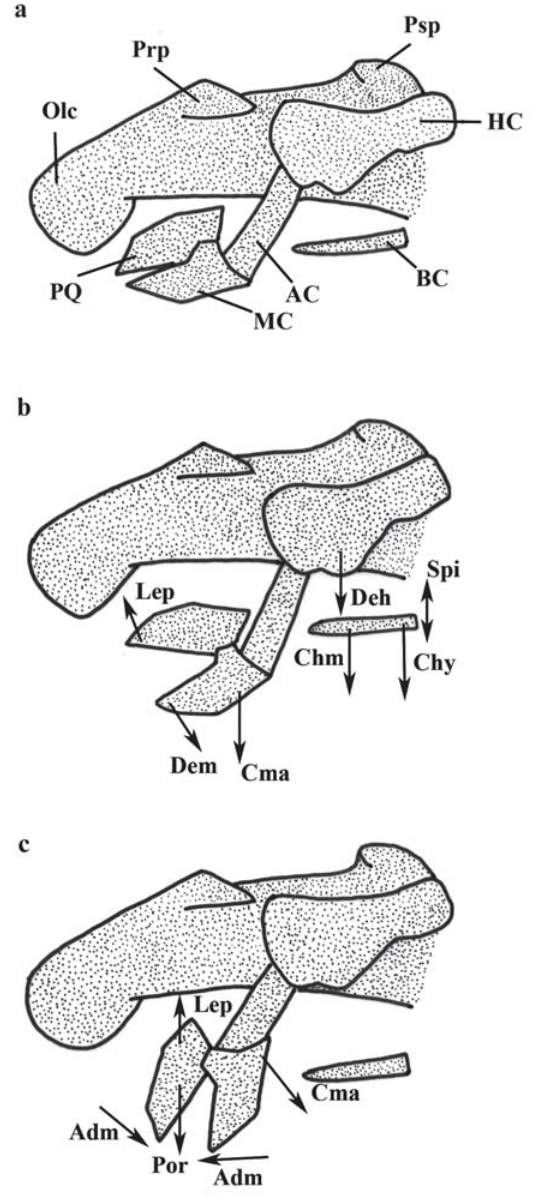
Fig. 6. Lateral view of the cranium of Potamotrygon motoro , showing the jaws movements during prey capture. From the resting position ( a ), mandibular, hyomandibular and basihyal cartilages depress and the mouth opens ( b ), followed by jaw protrusion. ( c ) The mouth closes after prey apprehension. Arrows indicate the direction of each muscles action. Adm, adductor mandibulae ; AC, angular cartilage; BC, basihyal cartilage; Car, coracoarcualis ; Chm, coracohyomandibularis ; Chy, coracohyoideus ; Cma, coracomandibularis ; Cuc, cucullaris ; Deh, depressor hyomandibulae ; Dem, depressor mandibulae ; E, eye; Epa, epaxialis ; HC, hyomandibular cartilage; Leh, levator hyomandibulae ; Lep, levator palatoquadrati ; M, mouth; MC, meckelian cartilage; NA, nostril aperture; Por, preorbitalis ; Sbc, superficial branchial constrictor ; Spi, spiracularis